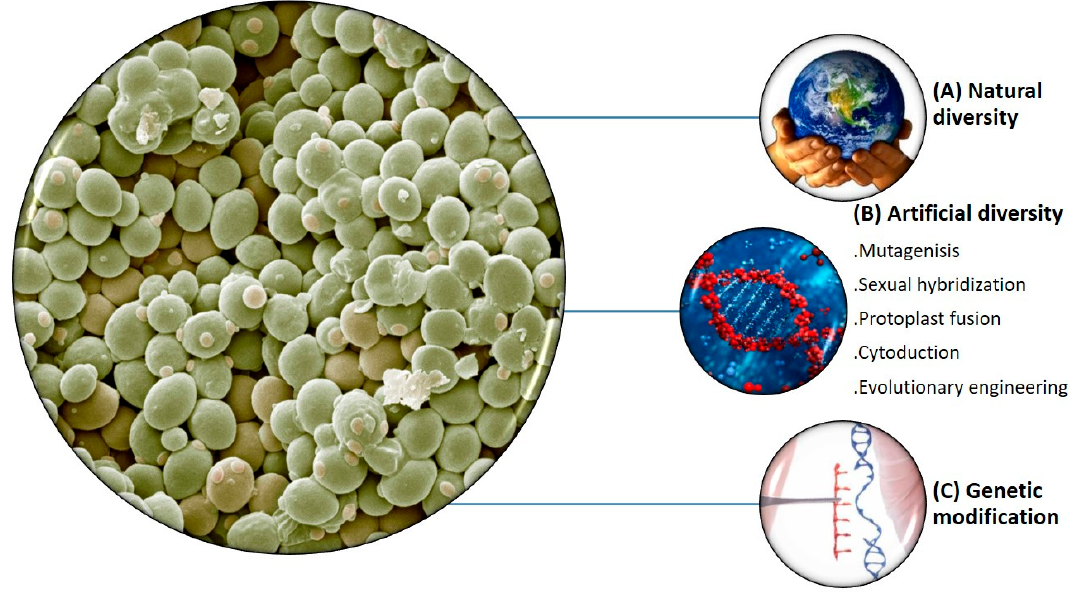
Figure 1. Overview of strategies to obtain superior industrial yeast strains: ( A ) Natural diversity; ( B ) Artificial diversity and ( C ) Genetic modification. Adapted from Steensels et al. [17].